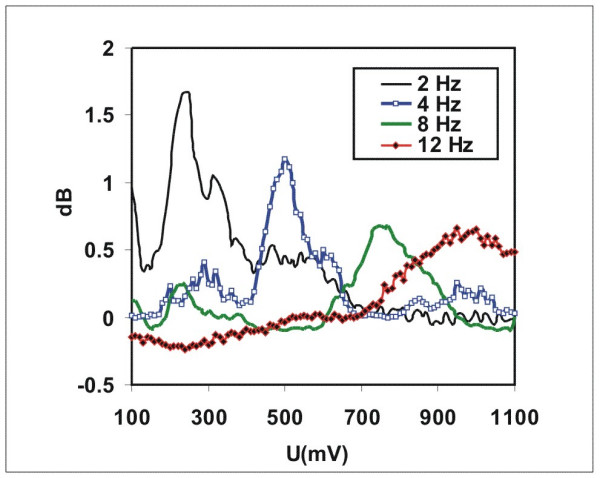
Extracted voltage courses of the DNLDS resolved voltammogram dataset. Voltammograms for some harmonics of the DNLDS resolved voltammogram dataset (sine wave 2 Hz with variable amplitude 100–1100 mV, not normalized here, see text for details) of a glutamic acid / HCl solution (2.24 mM, pH 2.85) under ICR Conditions (Bdc = 40 μT, Bac = 50 nT, 4.14 Hz).